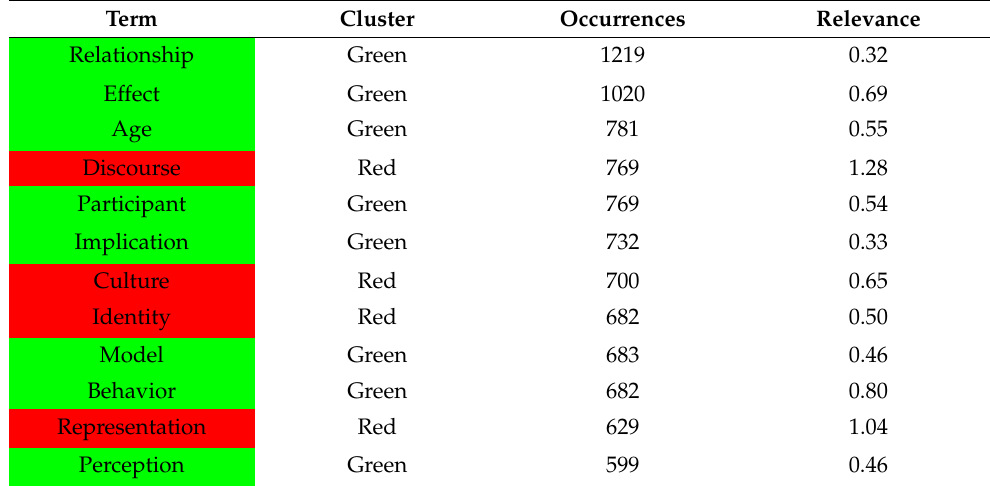
Table 6. Top 50 keywords according to